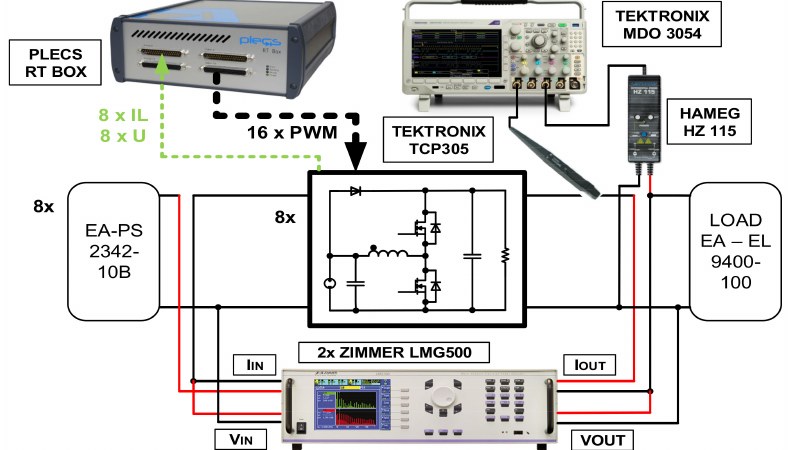
Figure 14. Block diagram of the principal configuration of the experimental test set-up during the evaluation of the efficiency characteristic for the Bi-BB converter.